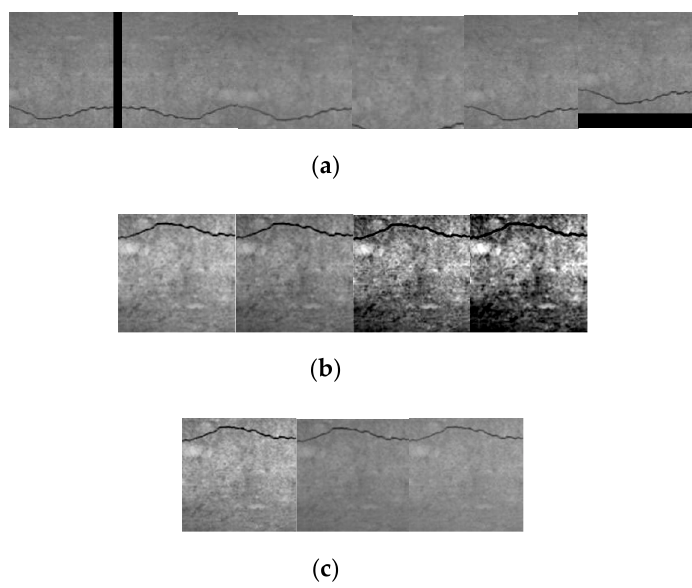
Figure 13. ( a ) Images with different jittering parameters, showing that the range was 10% of the whole picture. ( b ) The state of the picture after adding Gaussian noise at different intensities (10%, 20%, 30%, and 40%). ( c ) Different gamma curves.